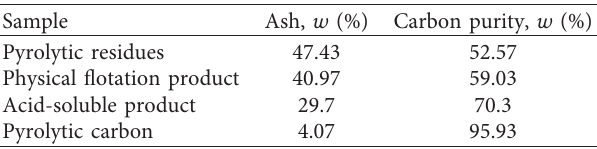
Wastewater Discharge Standard.” Table 3: Ash and carbon purity of pyrolytic residues at different stages.